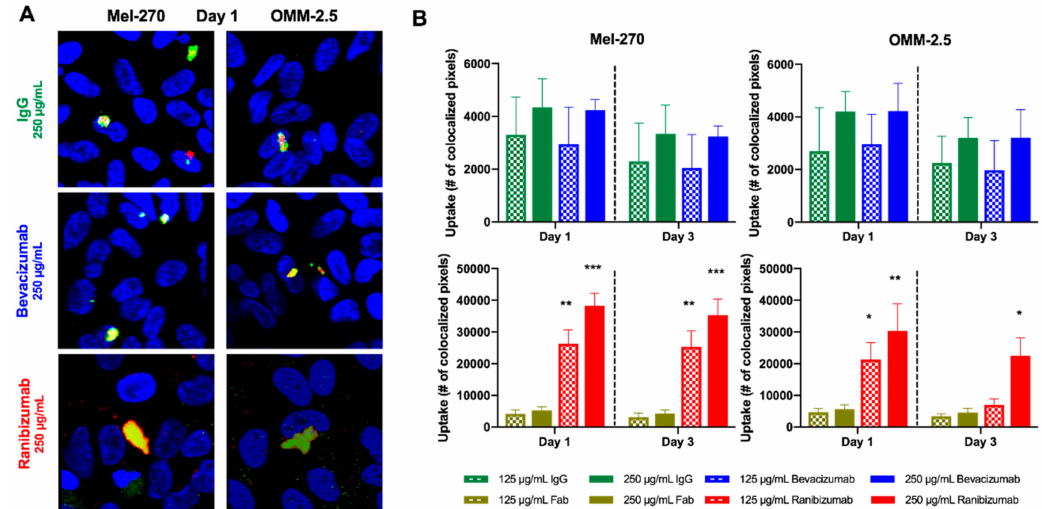
Figure 4. Intracellular uptake of bevacizumab and ranibizumab into UM cells after a one-day exposure to these antibodies. Cells were incubated with fluorescently labeled bevacizumab or ranibizumab for one day, then maintained in daily replaced untreated medium for up to three days. ( A ) Colocalization of the Dylight650-labeled drugs (red) with Alexa488-labeled, Rab5-positive endosomes (green) was evaluated by confocal microscopy. Cell nuclei were stained with DAPI (blue). Images were acquired at 400 × magnification. ( B ) Considerable amounts of ranibizumab, but not bevacizumab were taken up into both Mel-270 and OMM-2.5 cells. While the accumulation of ranibizumab in the Mel-270 cultures persisted well for three days, its levels subsided in the OMM-2.5 cells after three days, with only the double dose of 250 µ g / mL being detected at significantly higher levels compared to the isotype control. * p < 0.05, ** p < 0.01, *** p <